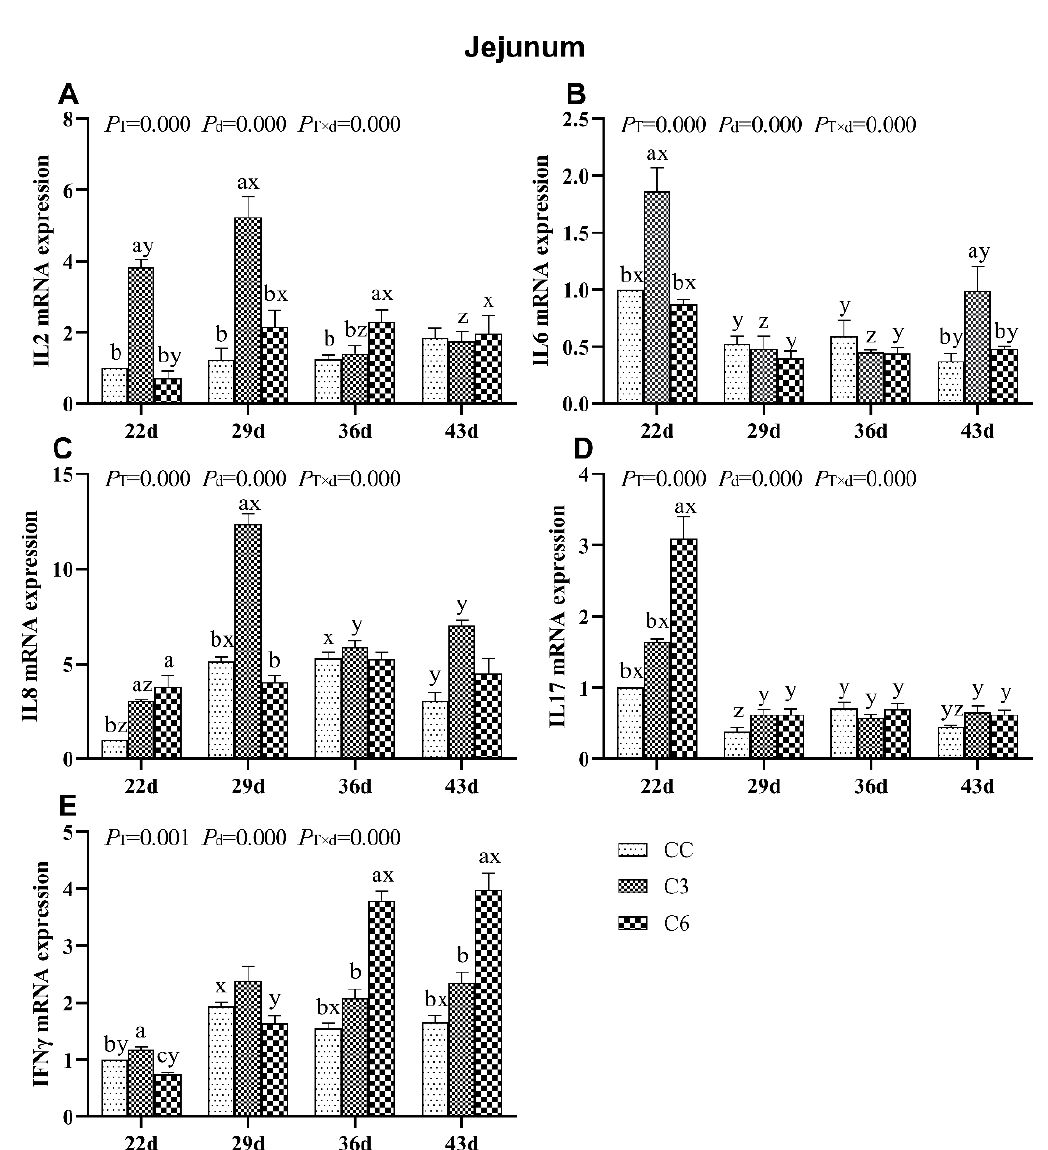
Figure 4. mRNA levels of cytokines IL2 ( A ), IL6 ( B ), IL8 ( C ), IL17 ( D ), and IFNγ ( E ) in the jejunum of broilers. Different letters indicate significant differences ( p < 0.05) between treatment groups (a, b, c) and days of age (x, y, z).